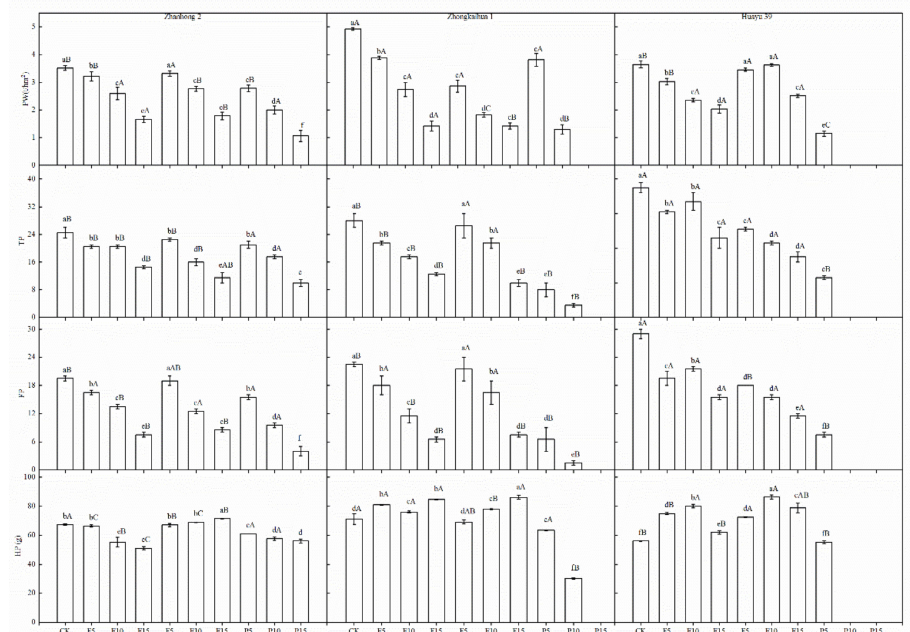
Figure 7. E ff ects of waterlogging stress on the yield and yield components. Note: data are presented as the average value ( n = 3). Di ff erent lowercase letters indicate statistically significant di ff erences among the waterlogging stress treatments ( p < 0.05) in the same genotype, as determined by the least significant di ff erence test. A, B, and C indicate statistically significant di ff erences between di ff erent ecotypes under the same waterlogging stress treatments ( p < 0.05), as determined by the least significant di ff erence test. CK: control (plants without waterlogging stress); treatments: plants with waterlogging stress. S5, S10, S15, F5, F10, F15, P5, P10, P15 indicate the waterlogging stress for 5, 10, and 15 days at the seedling, flowering, and pod-filling stages, respectively; TP: total pods per plant, FP: full pods per plant, HP: hundred pods weight, YH: yield per